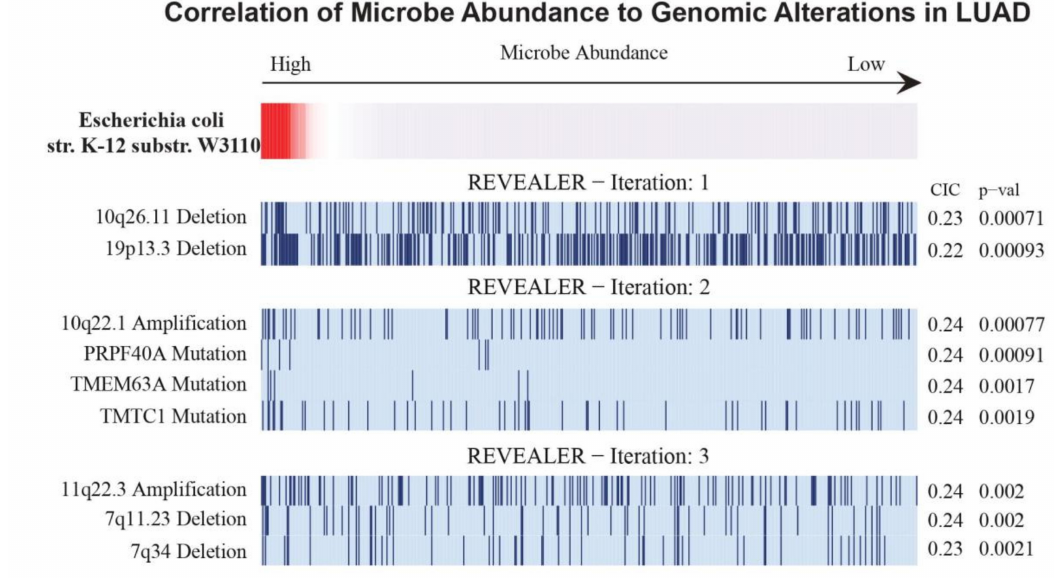
Figure 8. Association between genomic alterations and the abundance of a microbe in LUAD using RepeatedEvaluationofVariablesconditionALEntropyandRedundancy(REVEALER)(CIC > 0.2, p <